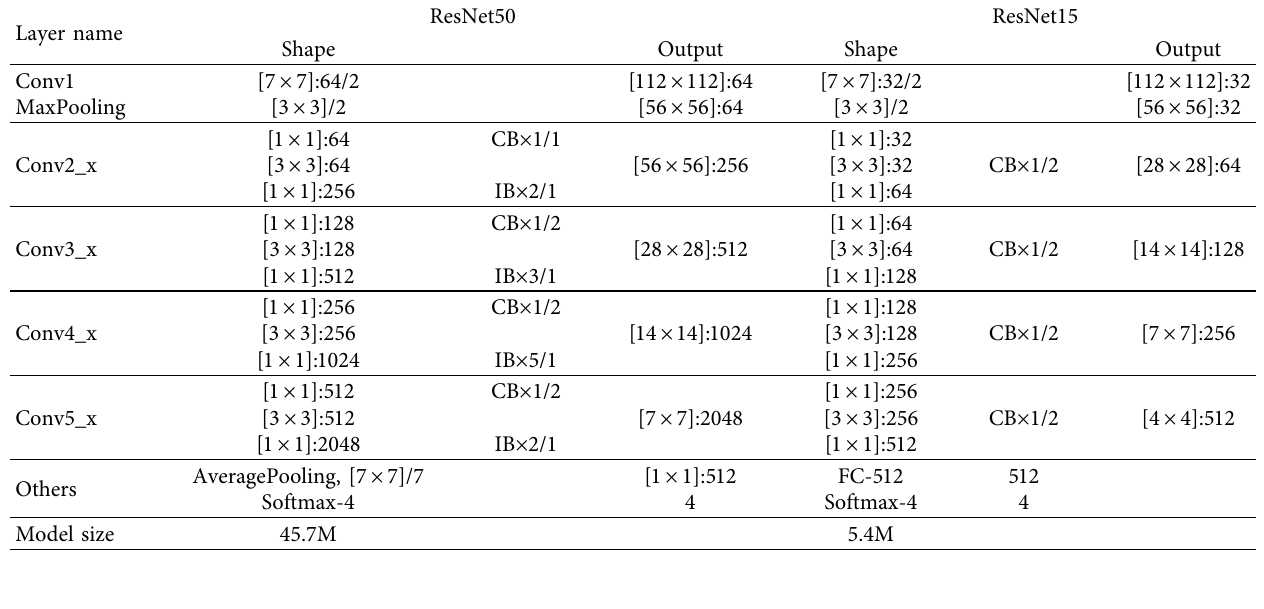
Table 2: Architecture of ResNet50 and ResNet15.